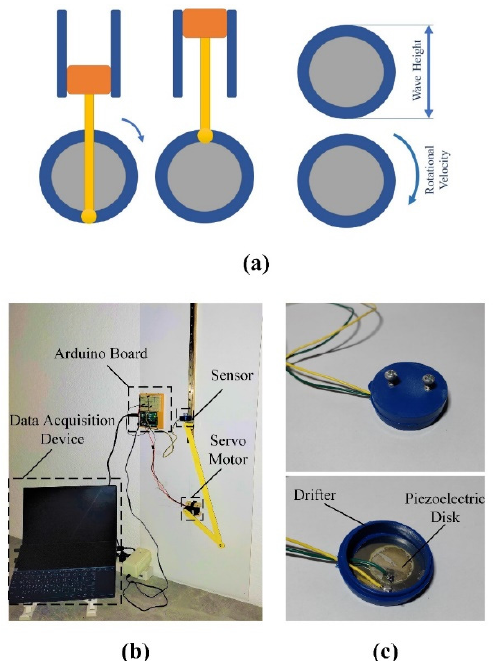
Figure 9. Experimental setup and results: ( a ) Slider-crank mechanism; ( b ) Experimental setup; ( c ) The fabricated sensor prototype for testing.